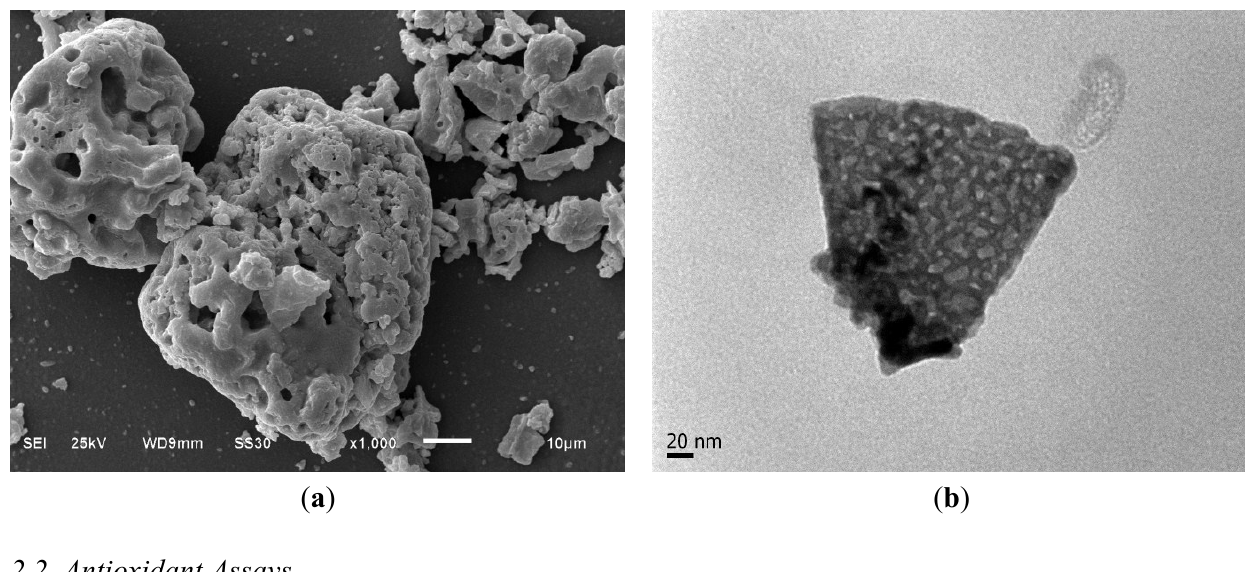
Figure 7. ( a ) Scanning electron microscopy (SEM) and ( b ) transmission electron microscopy (TEM) images of Sample Y-12 at 1000× and 300,000×,